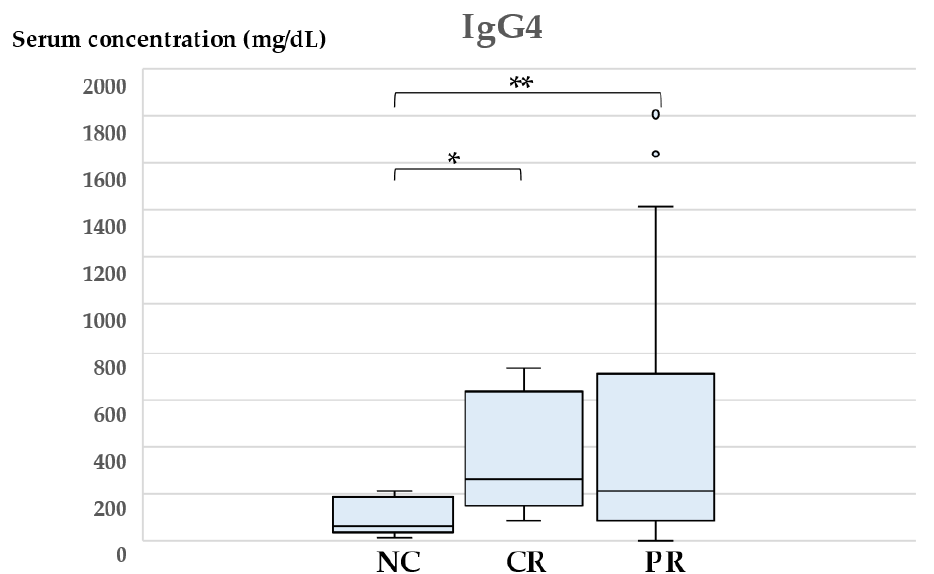
Figure 2. Serum concentration of IgG4 in each group classified by response to glucocorticoid therapy. Intergroup differences were analyzed using the Mann–Whitney U -test. A p value < 0.05 was considered statistically significant. IgG4, Immunoglobulin G4; sIL2-R, soluble interleukin-2 receptor; NC, no change; CR, complete response; PR, partial response. * p = 0.0059; ** p = 0.0078. ROC analysis was performed between nonresponder (NC, n = 11) and responder groups (CR and PR, n = 60) to identify the cut-off value of serum IgG4 as a predictive marker. ROC curve, cut-off value and area under the curve (AUC) are shown in Figure 3. As a result, the cut-off value was 67.6 mg/dL, and AUC was 0.793. The values of sensitivity and specificity were 0.85 and